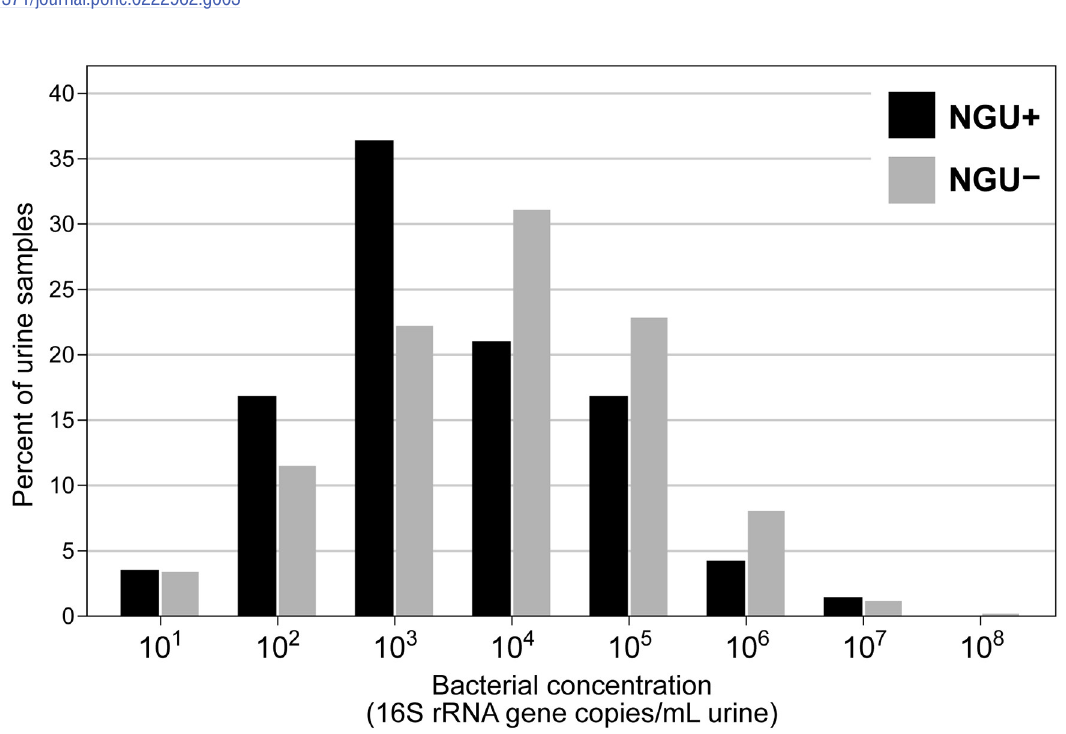
Fig 4. Distribution of bacterial DNA extracted from urine samples treated with 10% v/v Tris-EDTA. Data shown for 955 urine specimens including 143 specimens that were from NGU+ men and 812 specimens that were from NGU- men. An additional 43 samples had bacterial concentrations below the lower limit of detection (16 = NGU+ men and 27 = NGU- men). Bacterial concentrations were significantly lower in men with NGU.